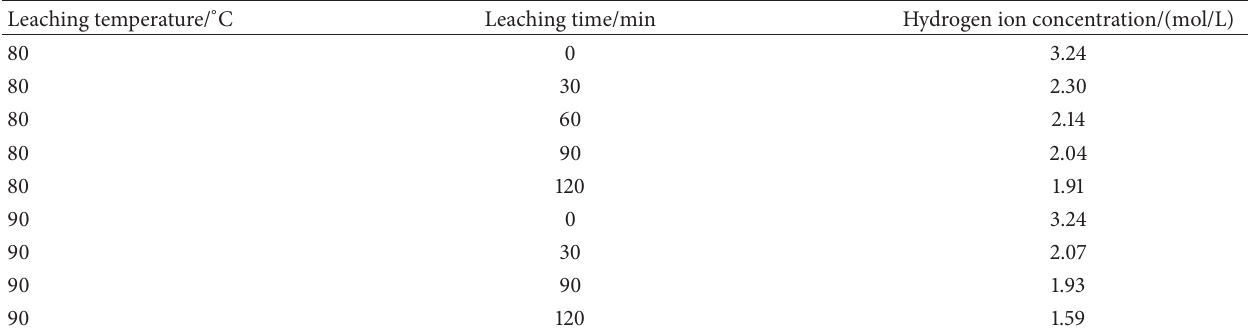
Table 3: Hydrogen ion concentration at a given time.